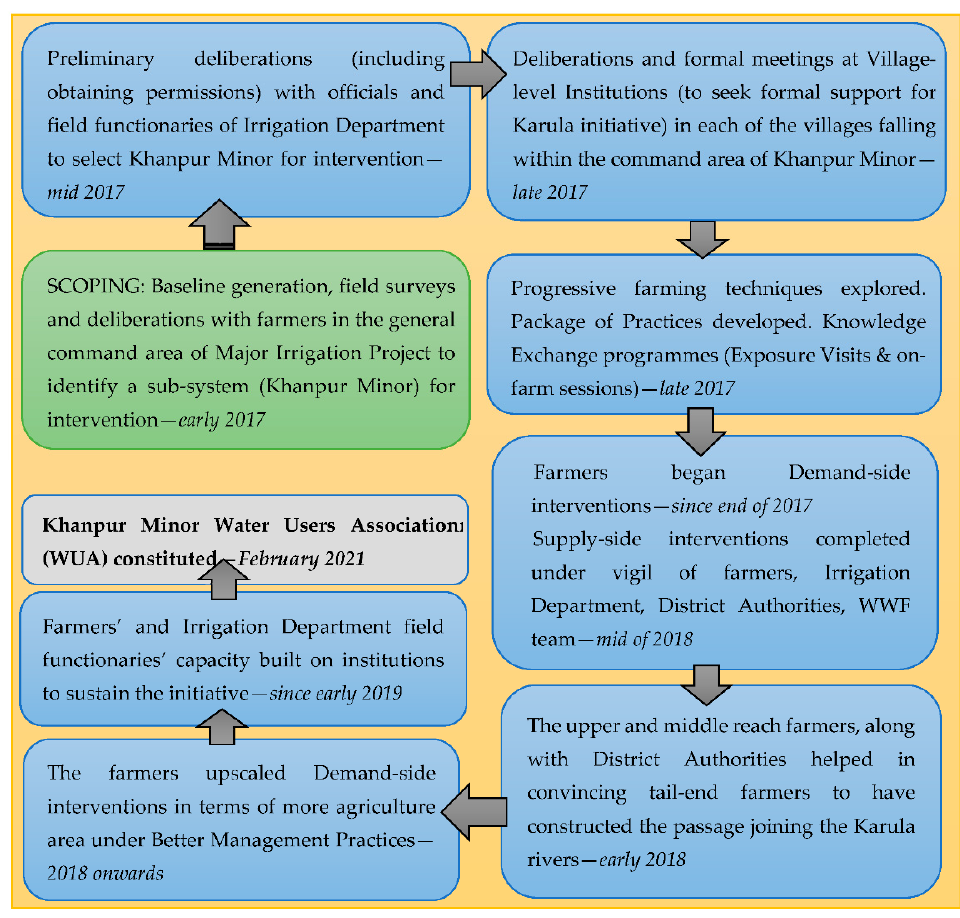
Figure 3. Stakeholder’s engagement, along with timelines and key steps and milestones.